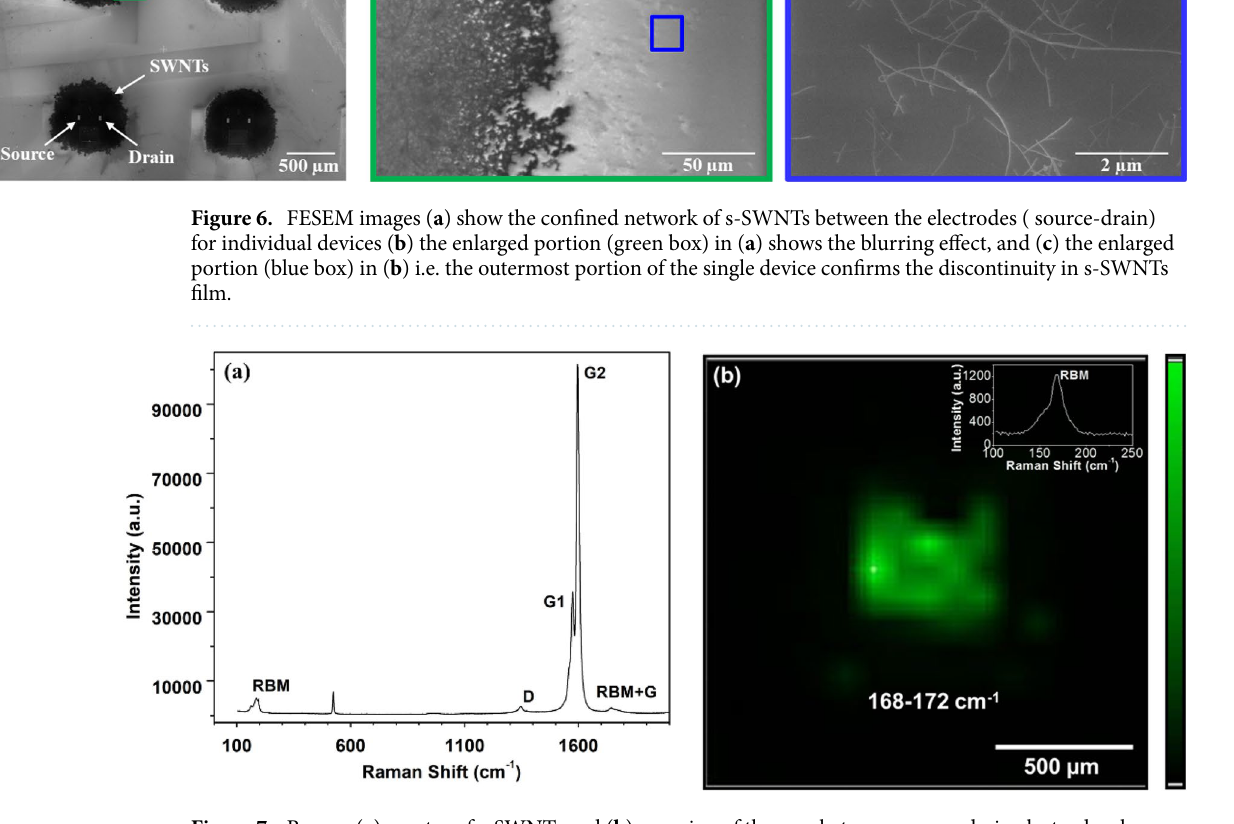
Figure 7. Raman ( a ) spectra of s-SWNTs and ( b ) mapping of the area between source-drain electrodes show the presence of s-SWNTs in the confined area of a single